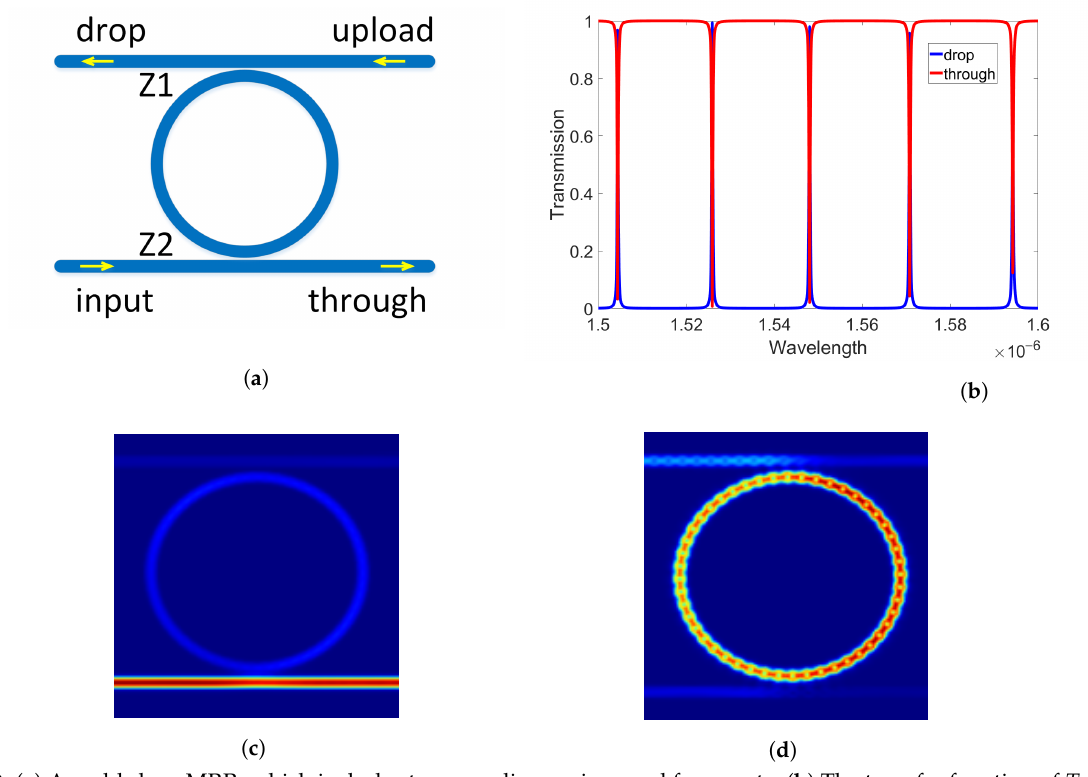
Figure 2. ( a ) An add-drop MRR, which includes two coupling regions and four ports. ( b ) The transfer function of T d - T p . The light has five resonances in different wavelengths, and the red curve represents the through port, and the blue one is the drop port. ( c ) The state of add-drop MRR without resonance, light is transmitted from the input to the through port. ( d ) The state of resonance. The light from the straight waveguide is transferred into the ring, and the effective index of refraction between the waveguide and the MRR and the circumference of the MRR cause the light to have a phase shift, thereby the intensity of the original light is interfered and finally outputs from the drop